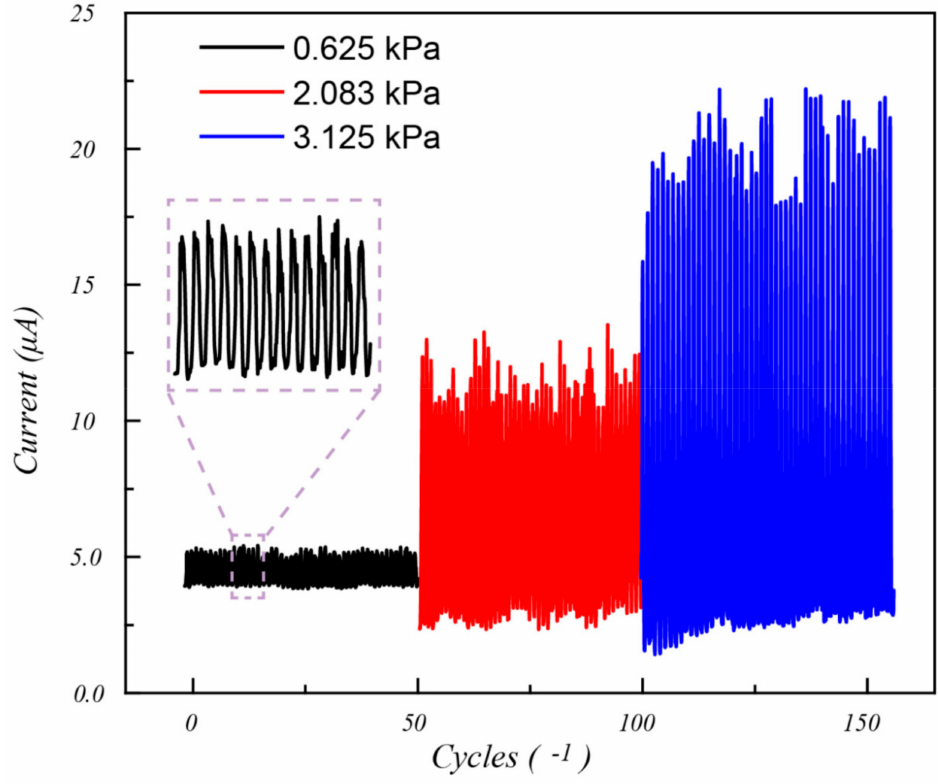
Figure 7. The 50 times cycling stability of the prepared reduced graphene oxide / polyurethane (rGO / PU) foam composite sensor under 0.625, 2.083 and 3.125